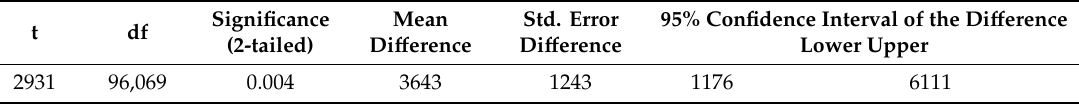
Table 4. Di ff erences in terms of MCM, between studies containing a CONSORT diagram or not (using Table 4. Differences in terms of MCM, between studies containing a CONSORT diagram or not the Independent Samples t -test). (using the Independent Samples t ‐ test) .